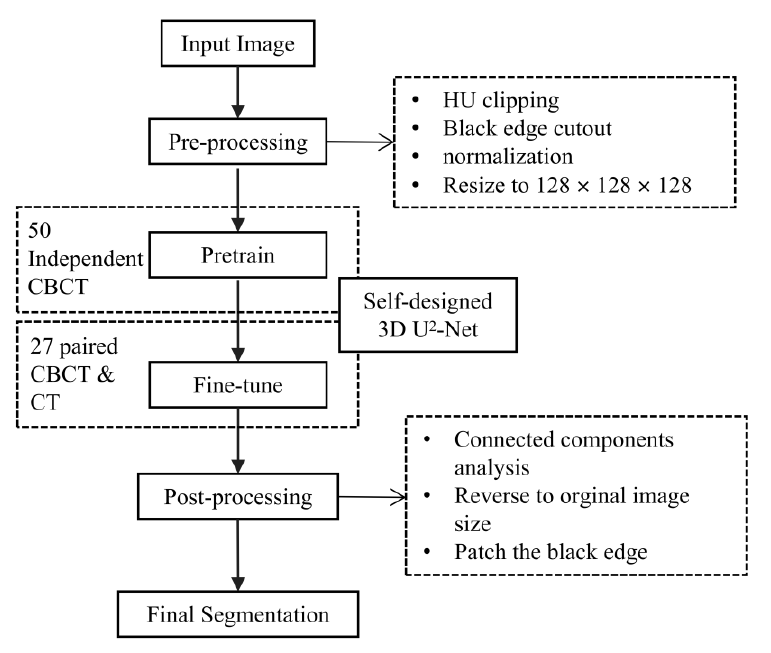
Figure 4. The flowchart of the proposed automatic segmentation method. CBCT, cone-beam computer tomography. CT, computer tomography. 3D, three-dimensional.